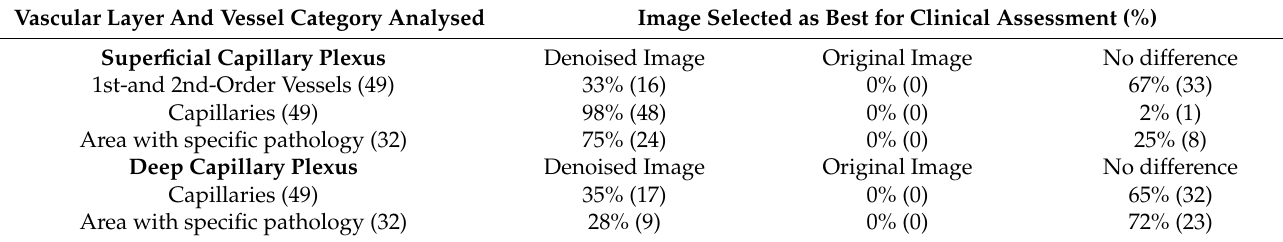
Table 1. Perceived better image overall for clinical